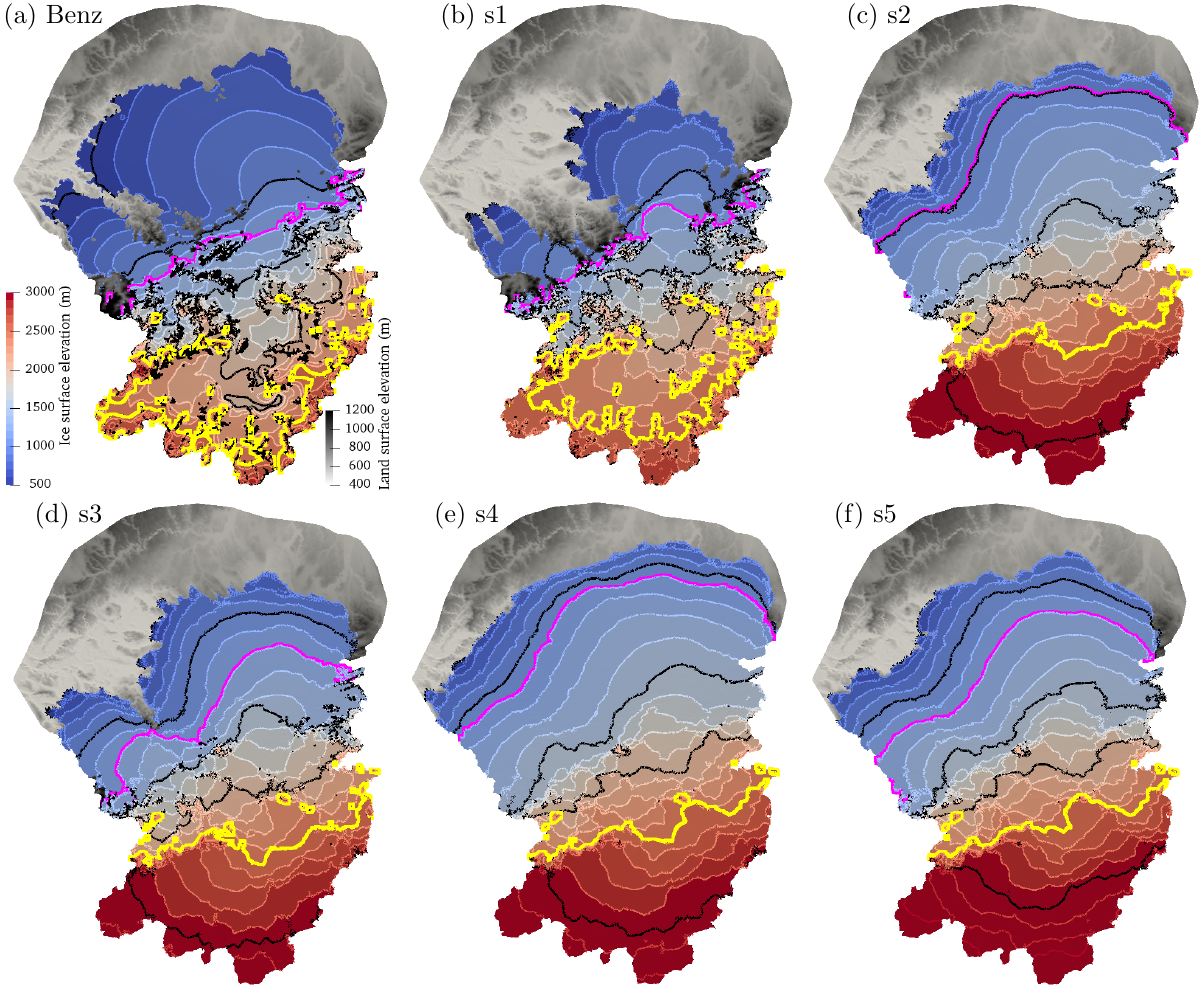
Figure 4. Ice surface elevation in meters above sea level for (a) Benz-Meier (2003) and (b–f) simulations s1 through s5. Black contours are every 500m. The 2500m contour is shown in yellow. The magenta contour indicates the equilibrium line altitude. The equilibrium line is 1200m except for simulations s2 (1000m) and s4 (1100m). Topography is shown in ice-free areas with a different color scheme. In (a) the northern extent of the Rhine and Linth glacier lobes are based on mapping of terminal